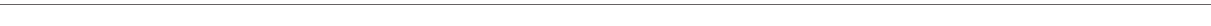
FiGURe 1 | Effect of advanced maternal age on oocyte/embryo competence and putative mechanisms impaired by aging. Aging in women causes both a reduction of the ovarian reserve and of the oocyte competence. All the processes impaired may result into a lower energy production/balance involving a small reduction of embryo developmental rate to the blastocyst stage, as well as a higher frequency of chromosome missegregation during maternal meiosis leading to a high increase in blastocyst aneuploidy rate (especially in women older than 35) [ data adapted from Franasiak et al . (10) and Capalbo et al. (11)]. Ultimately, these mechanisms converge into a decreased fertility, an increased prevalence of vital chromosomal abnormalities, an increased miscarriage rate, as well as an increased prevalence of numerical chromosomal abnormalities in the newborns [ data adapted from Hassold and Hunt (13) and Heffner (4)]. The aneuploidy rate is estimated per biopsied blastocyst; the fertility is estimated as number of babies born per 1,000 married women; the overall prevalence of vital aneuploidies is estimated per clinically recognized pregnancy; the miscarriage rate is estimated per clinical pregnancy; at last, the overall prevalence of numerical chromosomal abnormalities is estimated per number of